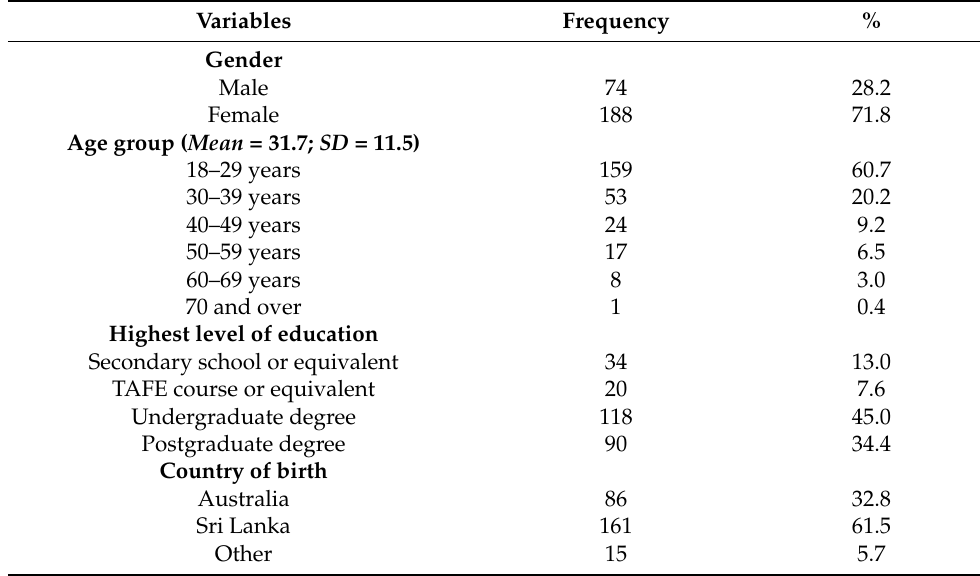
Table 1. Demographics and other characteristics of the sample ( N =